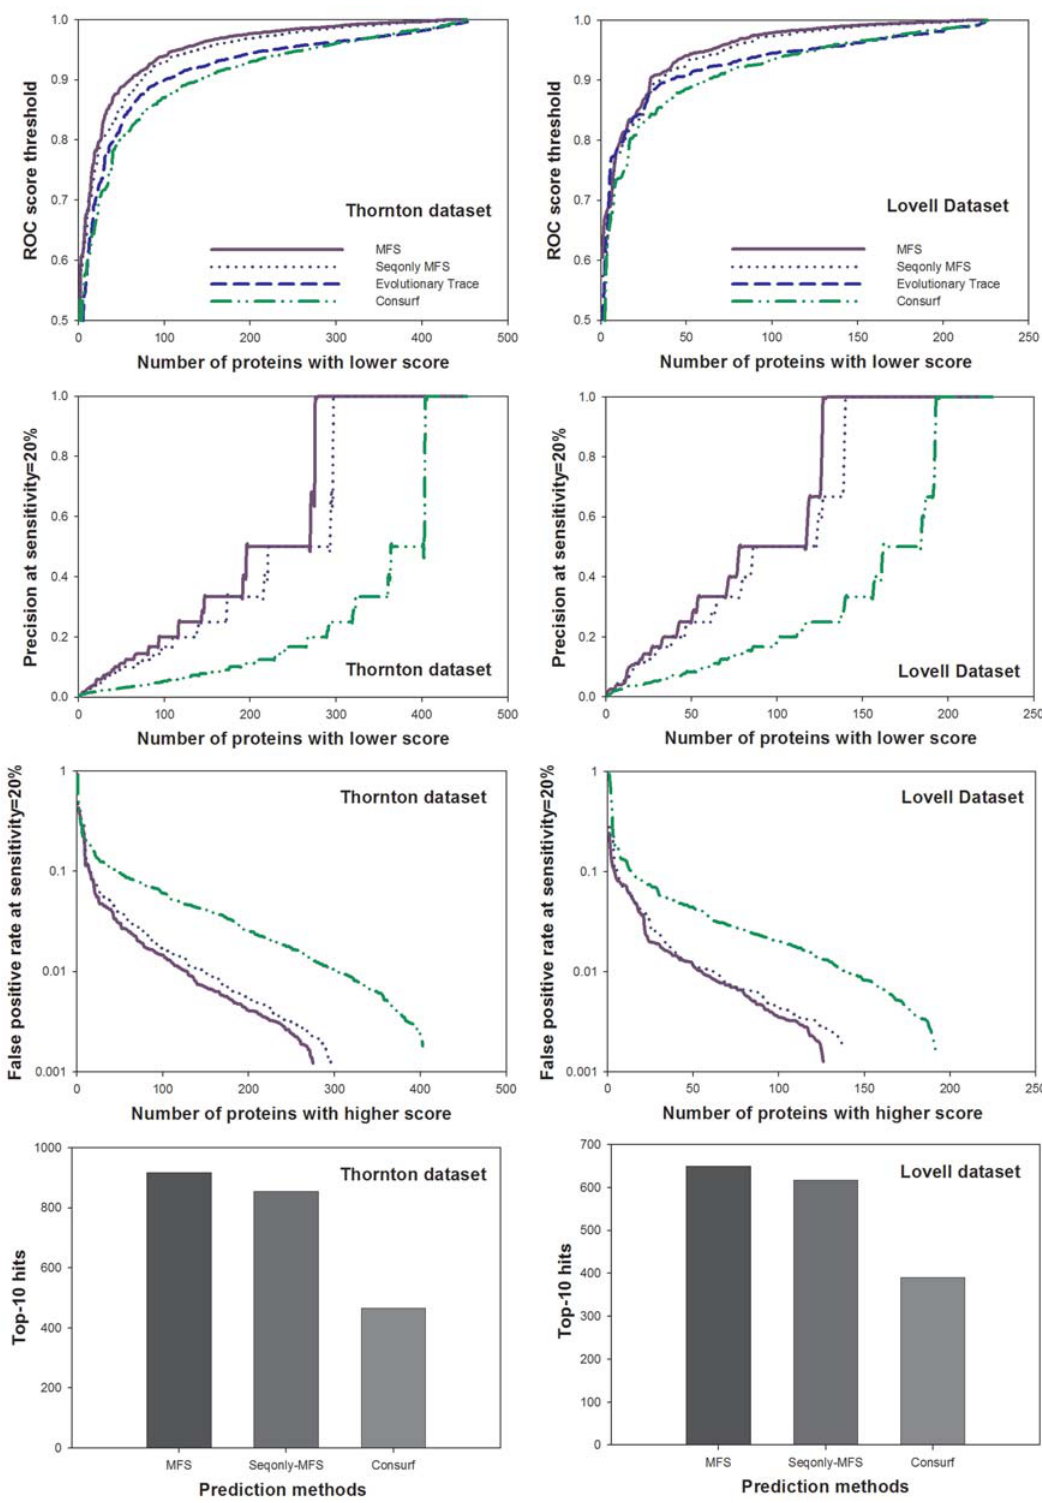
Figure 2. Performance comparison of the MFS method, the SeqonlyMFS method ( HMM_rel_ent + SSR + AAType ), the Evolutionary Trace method, and the ConSurf method with the Thornton and Lovell datasets. Only proteins for which both the Evolutionary Trace and ConSurf methods are able to give predictions are used in the comparison. Four measures are used to compare the performance, including: ROC scores, the precision when sensitivity threshold is set at 20%, the false positive rate when sensitivity threshold is set at 20% and the top-10 hits. ET is only used in the ROC score computation but not in other comparative analysis, since it gives many tied scores for top-scoring residues. Both the MFS and SeqonlyMFS methods have better performances than methods that use only one type of information.